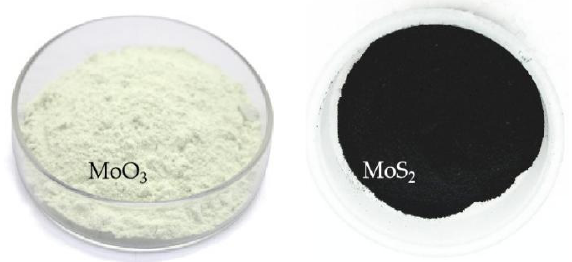
Figure 11. The images of DCLR and DCLR (ER).